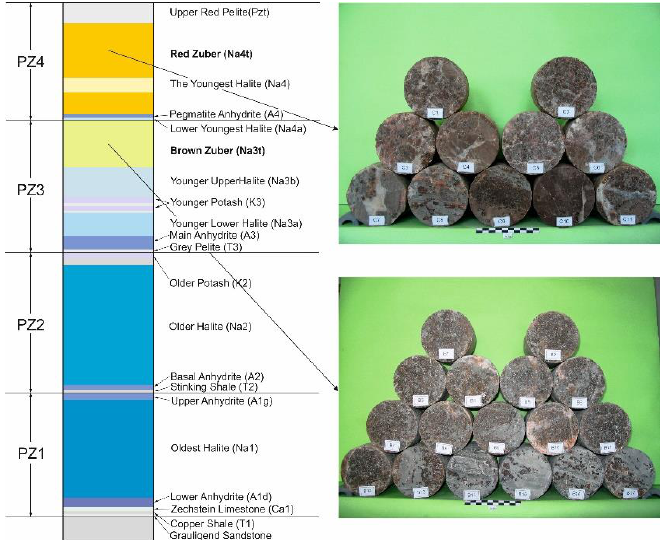
Figure 2. Example of core samples and the stratigraphic profile of the Zechstein deposits in the Central Poland region.